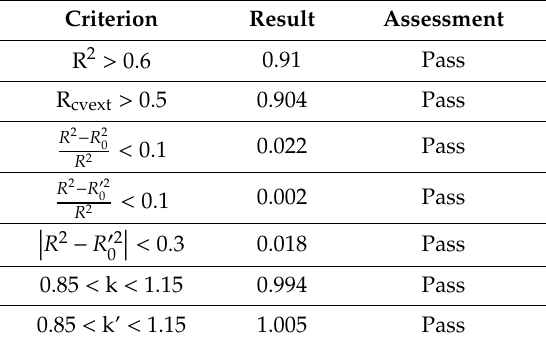
Table 1. Model validation criteria and acquired